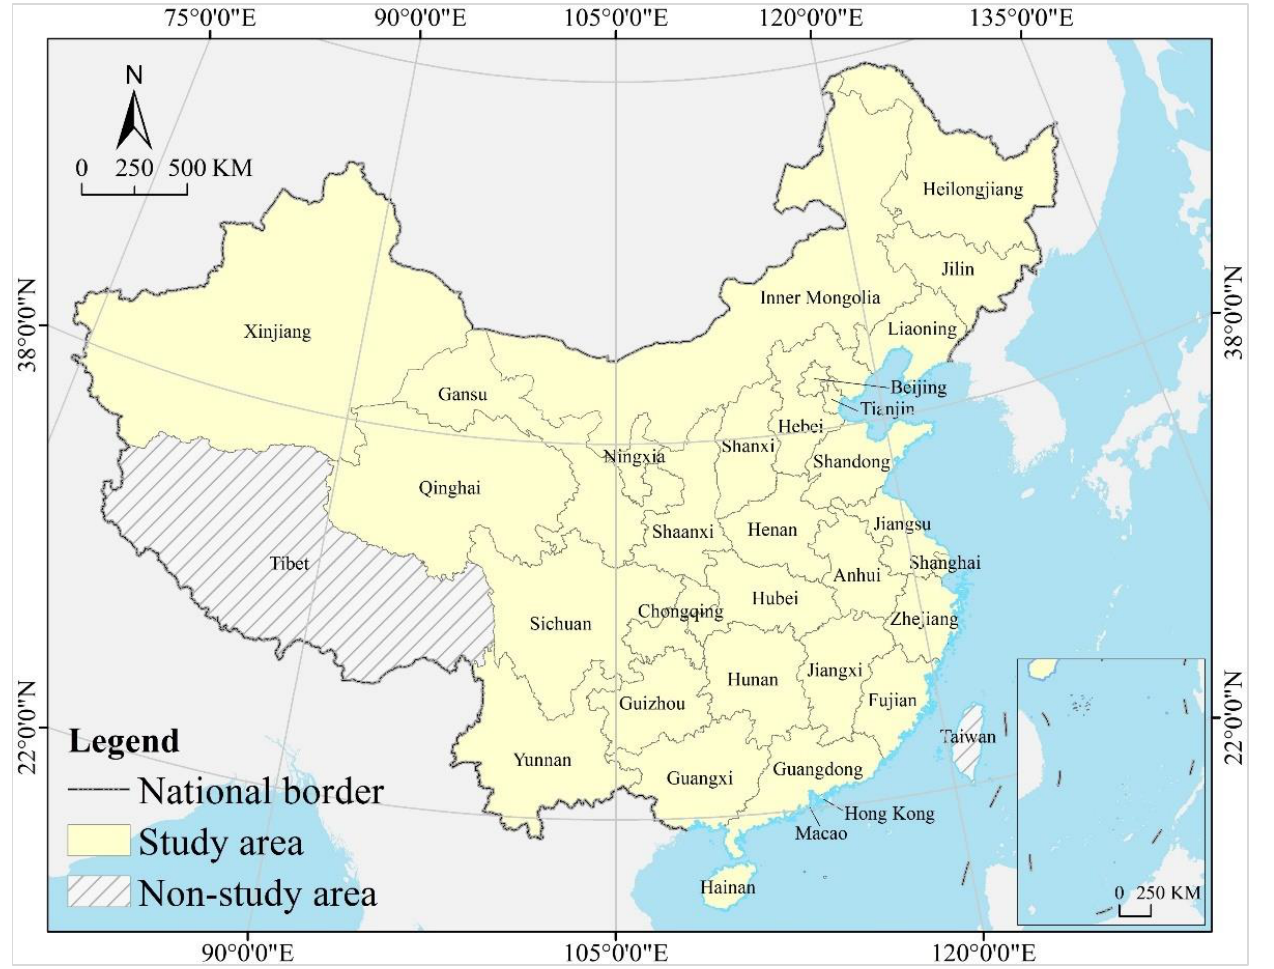
Figure 1. Research area.